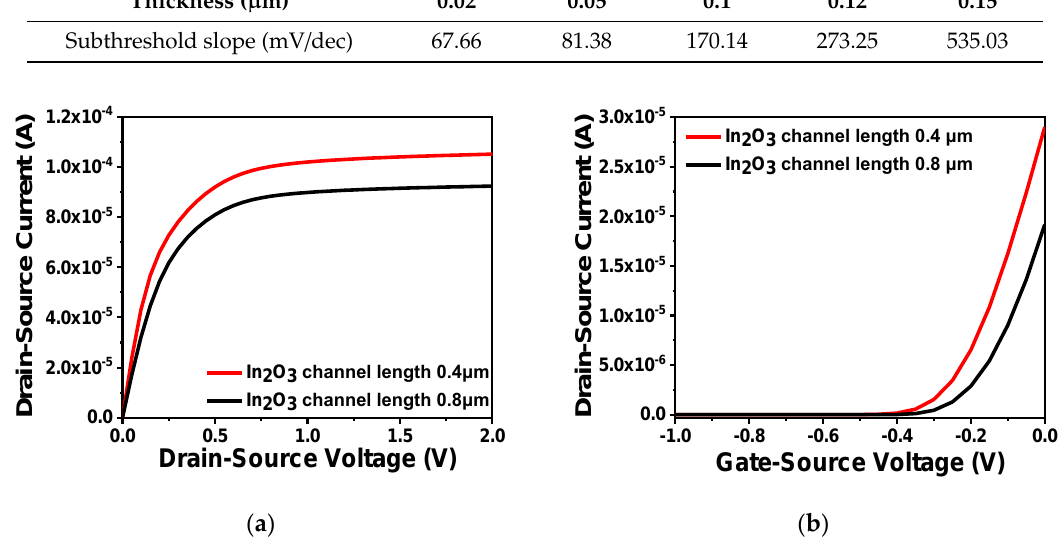
Figure 6. Characteristics of different channel lengths: ( a ) output characteristic curve of different channel lengths; ( b ) transfer characteristic curve of different channel lengths.